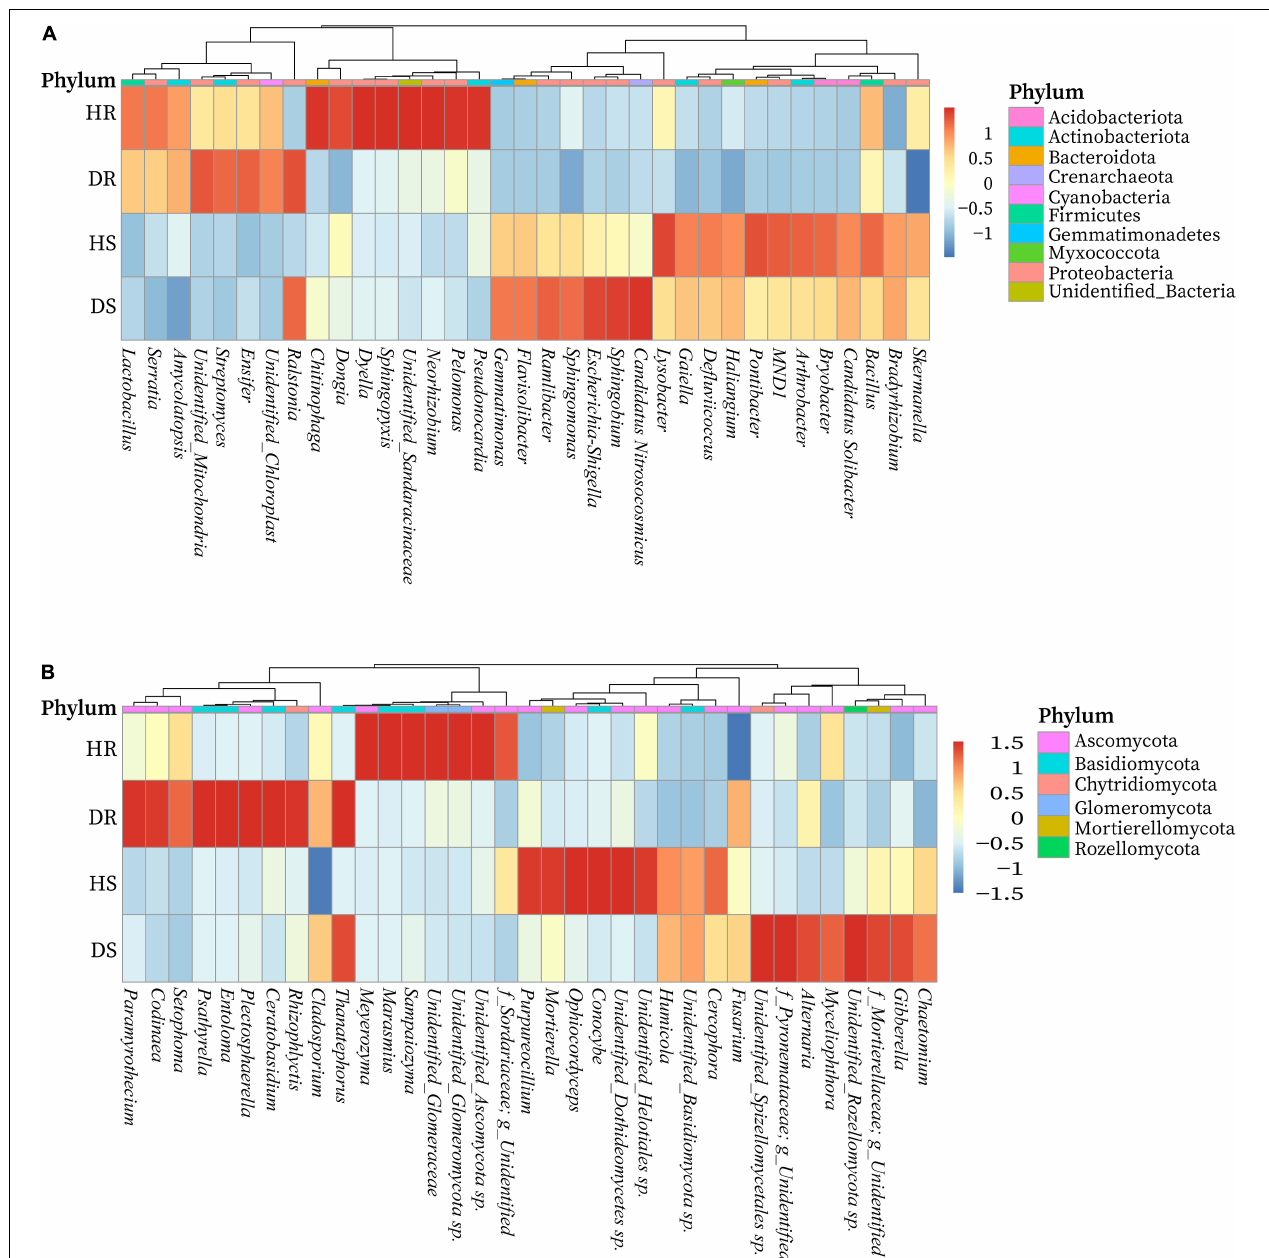
FIGURE 6 | Relative abundance heatmaps at the genus level for top 35 bacterial (A) and fungal (B) genera in group-wise comparison under three variables. HS, healthy rhizosphere soil; DS, diseased rhizosphere soil; HR, healthy roots; DS, diseased